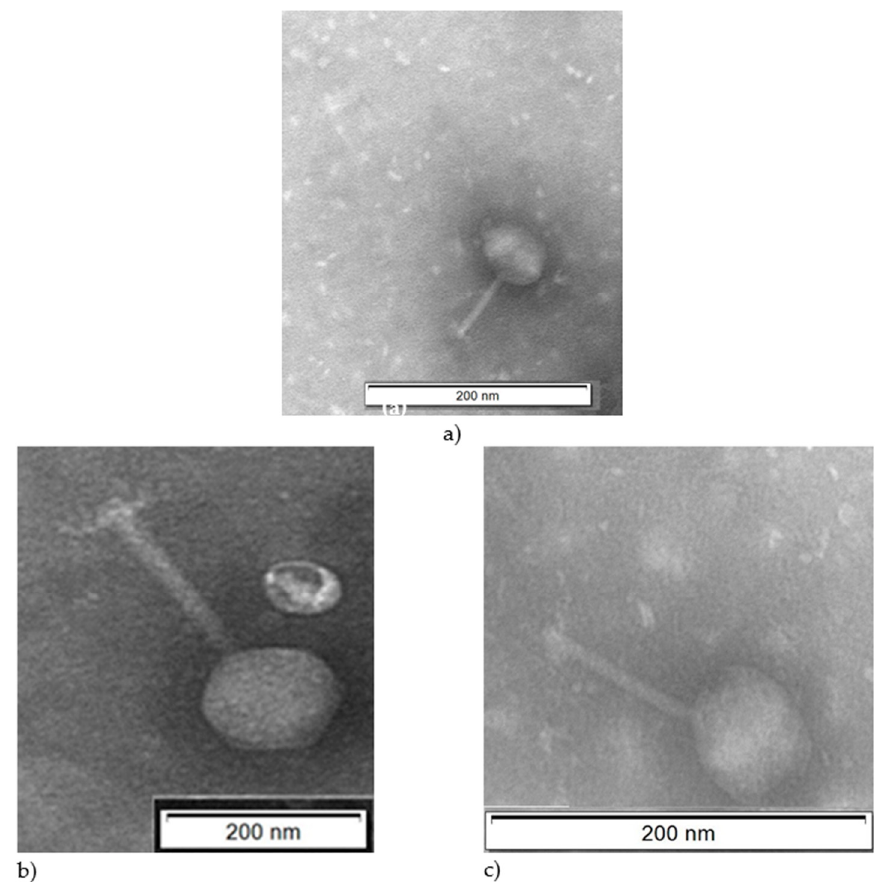
Figure 2. Transmission electron micrographs of the Vibrio bacteriophages isolated in this study. ( a ) Φ -5, ( b ) Φ -6, ( c ) Φ -7. Table 2. Characteristics of the Vibrio bacteriophages isolated in this study.